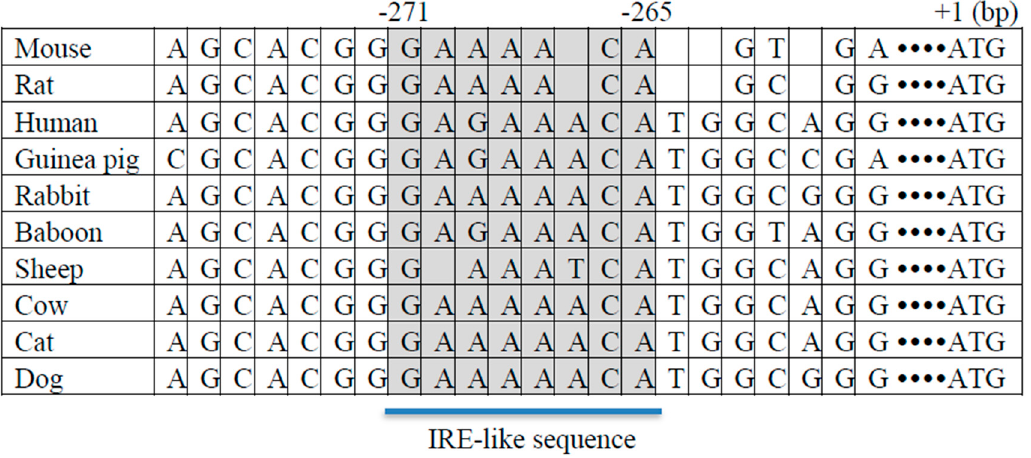
Figure 1. Putative insulin response element (IRE)-like sequence in FTO (Fat mass and obesity-associated) promoter. IRE-like sequence GAAAACA was identified in the mouse FTO gene promoter (271–265 bp upstream of the transcription start site). The putative IRE with surrounding sequence was aligned in 10 species including, mouse, rat, human, guinea pig, rabbit, baboon, sheep, cow, cat, and dog. The shaded region represents the IRE-like sequence.